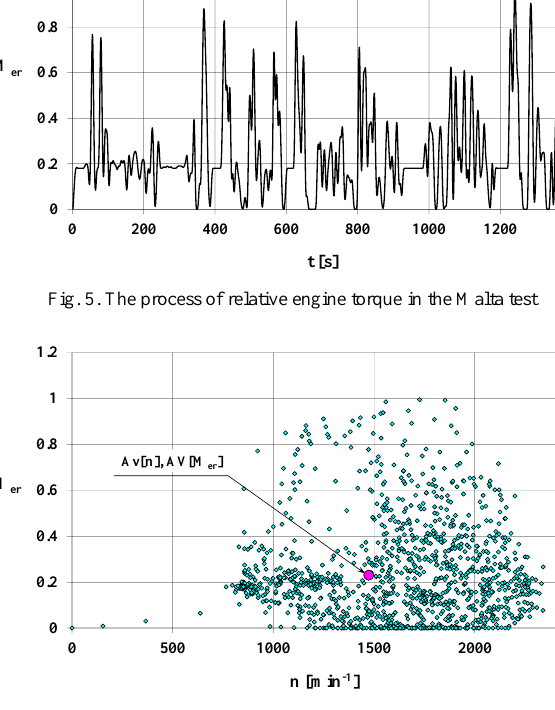
Fig. 6. Set of engine operating states in the Malta test The engine tests in the Malta test performed on an en- gine dynamometer were carried out for a thermally stabi- lized